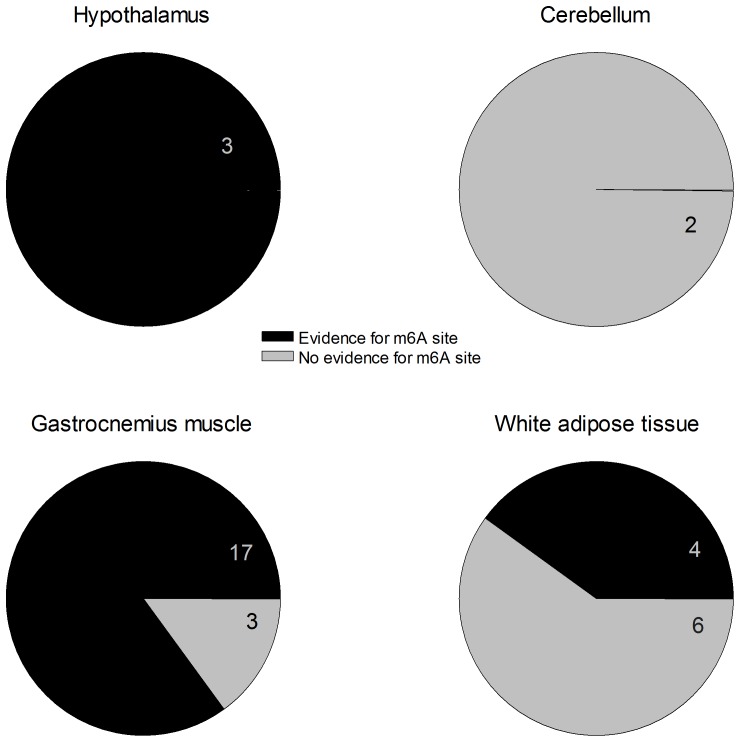
Effect of FTO overexpression on m6A levels in RNA.FTO mRNA expression in wild-type (black bar) and FTO-4 (white bar) MEFs as the fold change compared to wild-type (A). m6A levels measured as a percentage of adenosine levels for mRNA and total RNA by LC/MS in wild-type (black bar) and FTO-4 (white bar) MEFs (B). Significance was tested using Student's t-tests to compare FTO-4 to WT data. **p<0.01.